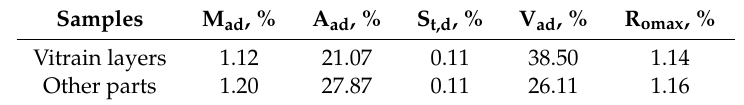
Table 1. Values of coal quality and maximum reflectance of vitrinite of coal with cleated structures from the Songhe coalmine, Liupanshui coalfield, Southwestern